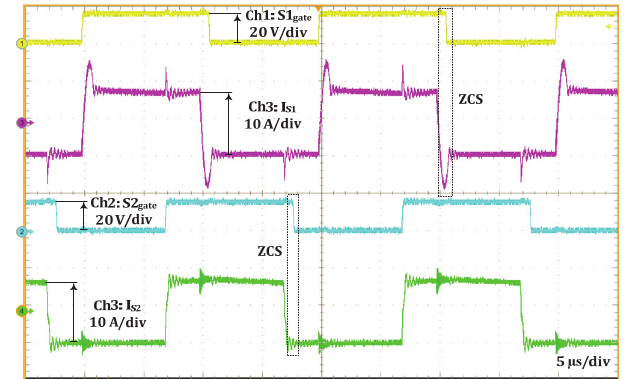
Fig. 4. Experimental waveforms of an APRC converter: Ch1 – S1 gate voltage, Ch2 – S2 gate voltage, Ch3 – S1 current and Ch4 – S2